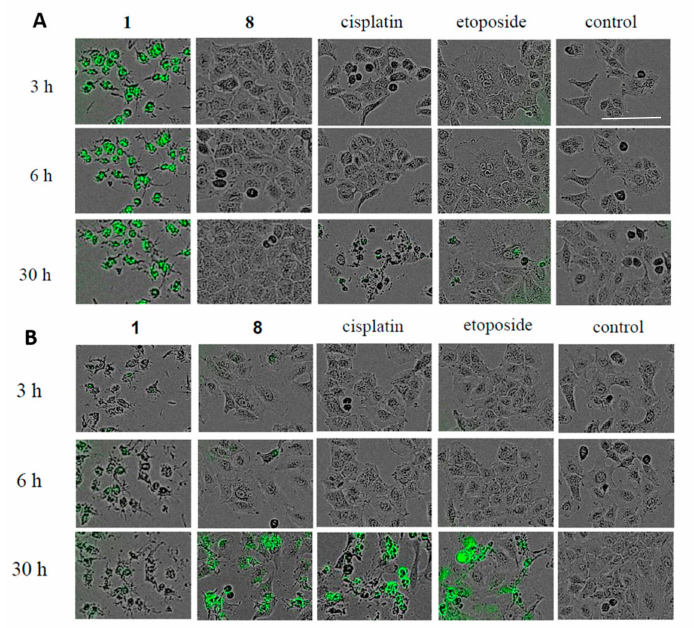
Figure 5. ( A ) Phase-contrast and fluorescent images of A549 cells stained with Cell Player TM 96-well caspase-3/7 Apoptosis Assay kit, showing morphological changes in response to 1 (20 µ M), 8 (20 µ M), cisplatin (33 µ M), and etoposide (33 µ M). ( B ) Phase-contrast and fluorescent images of A549 cells stained with YOYO-1, showing morphological changes in response to 1 (20 µ M), 8 (20 µ M), cisplatin (33 µ M), and etoposide (33 µ M). Scale bar = 100 µ